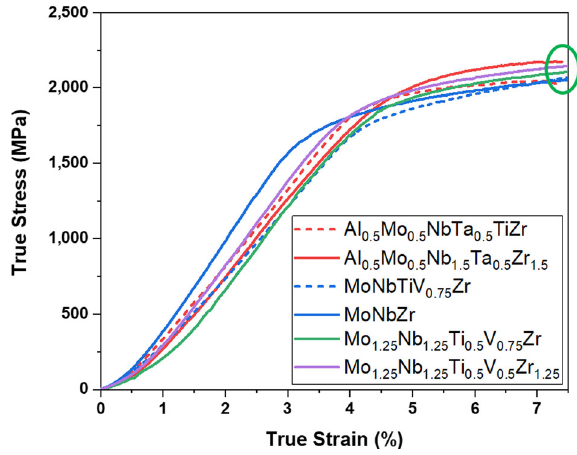
Fig. 5 Engineering stress – strain curves of the reference (dashed lines) and predicted (solid lines) compositions. For estimation of the error margins, refer to Table